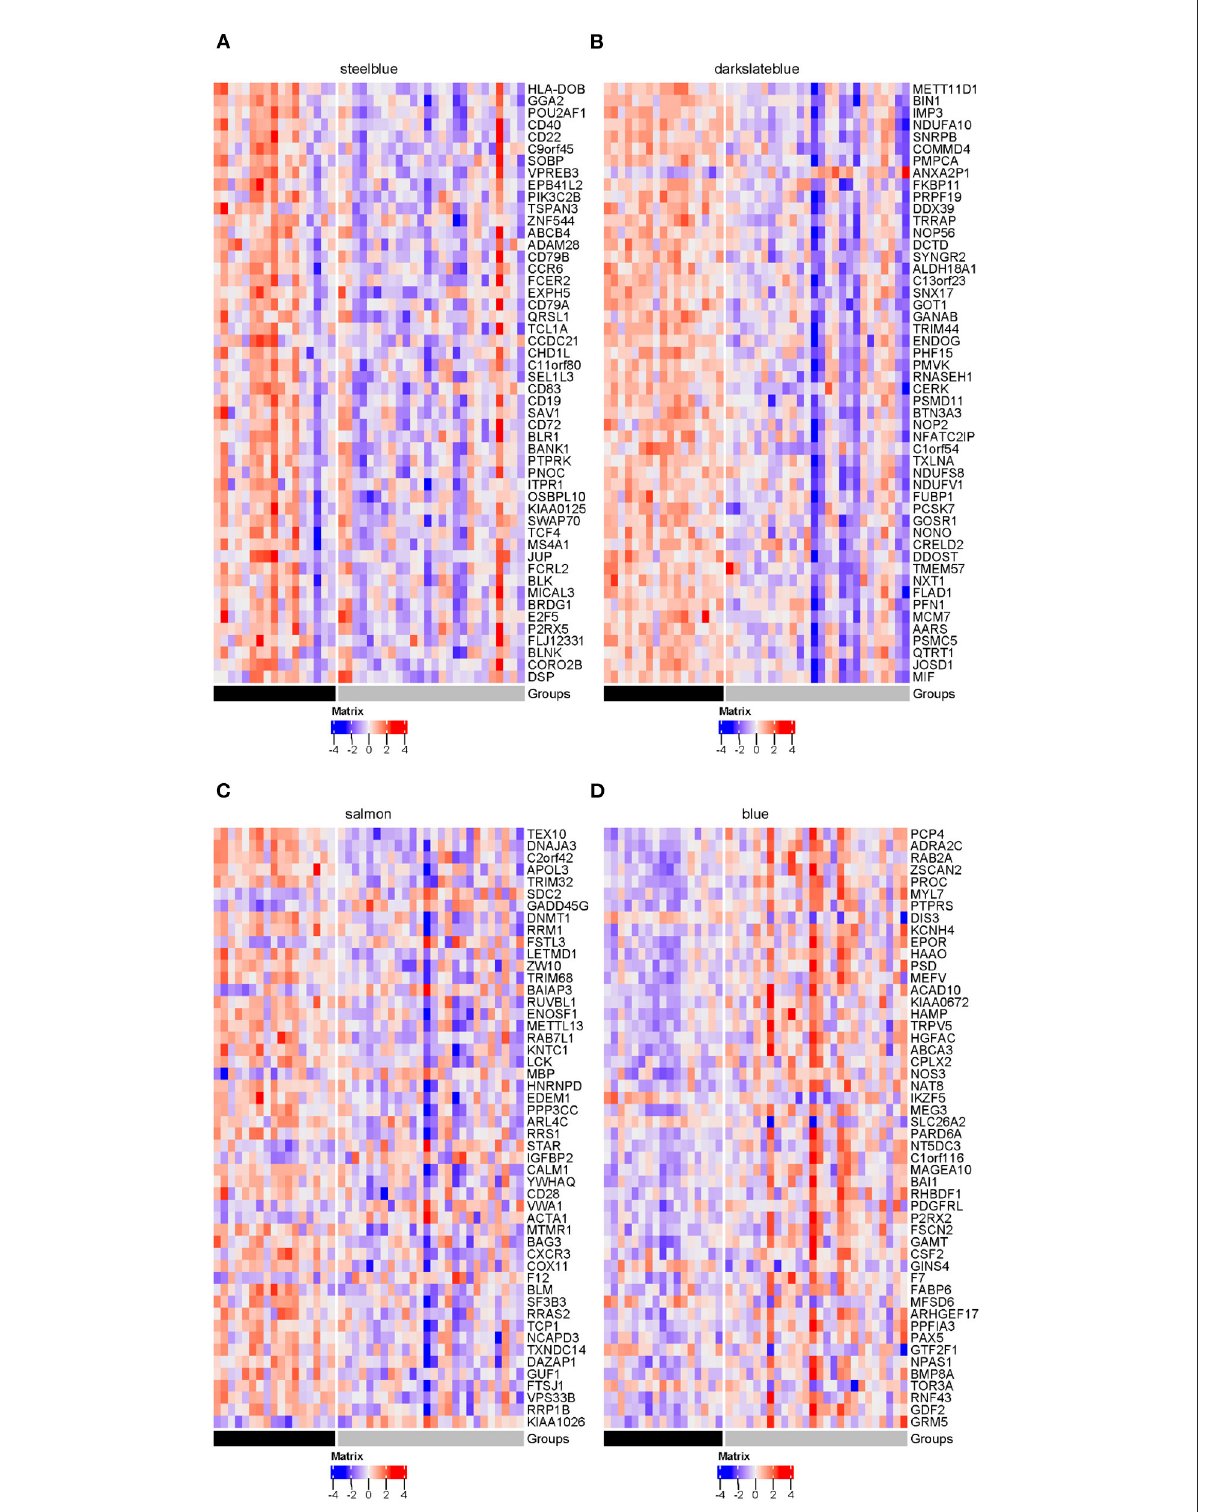
FIGURE13 Heatmaps of DEGs in four disease modules (gray = SI; black = AU): (A) steelblue, (B) darkslateblue, (C) salmon and (D) blue. The top 50 genes with the smallest FDR-adjusted p -value of differential expression are presented in these